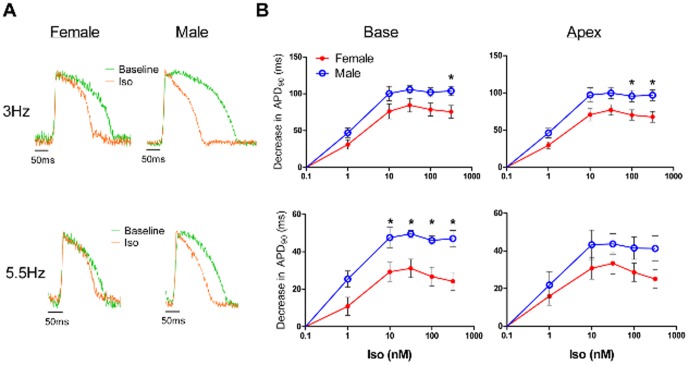
Less Iso-induced decrease of APD90 in female hearts.A) Representative APs at baseline (green traces) and during treatment with Iso (316.2 nM, orange traces) normalized and superimposed to demonstrate the sex difference in Iso effects during pacing at 3 Hz (top) and 5.5 Hz (bottom). B) Summary data for the decrease in APD90 (versus baseline values) as a function of the dose of Iso (1, 10, 31.6, 100, 316.2 nM) in the LV base (left) and apex of female (n = 5) and male (n = 5) hearts during pacing at 3 Hz (top) and 5.5 Hz (bottom). *p<0.05, female versus male.